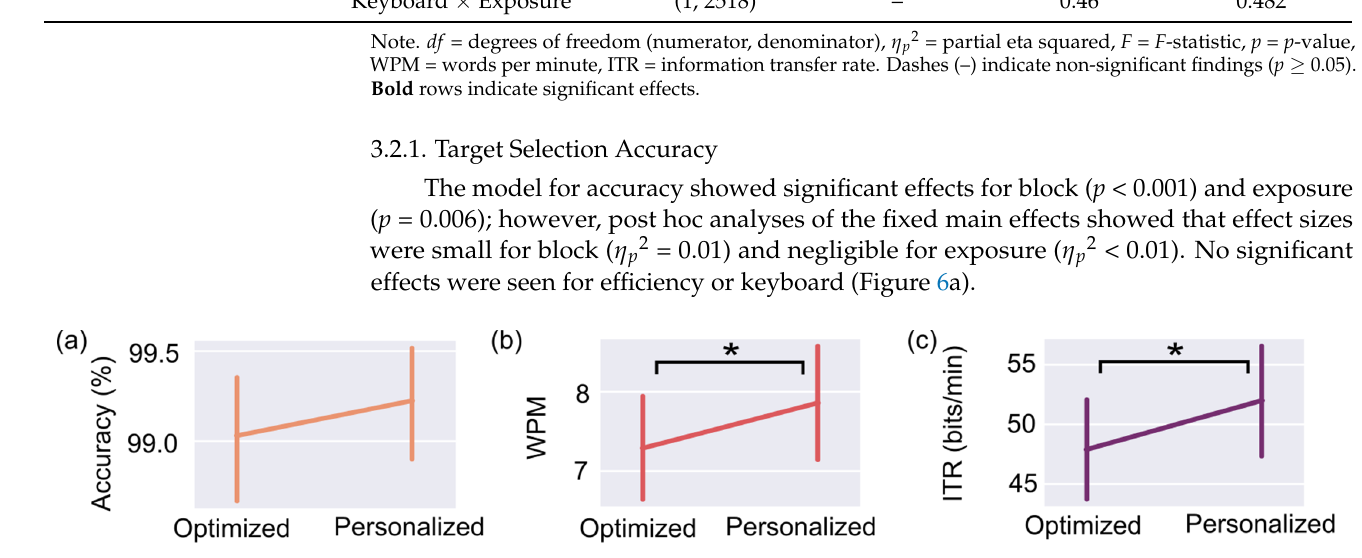
Figure 6. Marginal means for outcomes of transcription task when comparing optimized and personalized keyboards. ( a ) Target selection accuracy, ( b ) words per minute ( WPM ), and ( c ) information transfer rate ( ITR ) shown across keyboards. Error bars represent 95% confidence intervals. * p < 0.05.